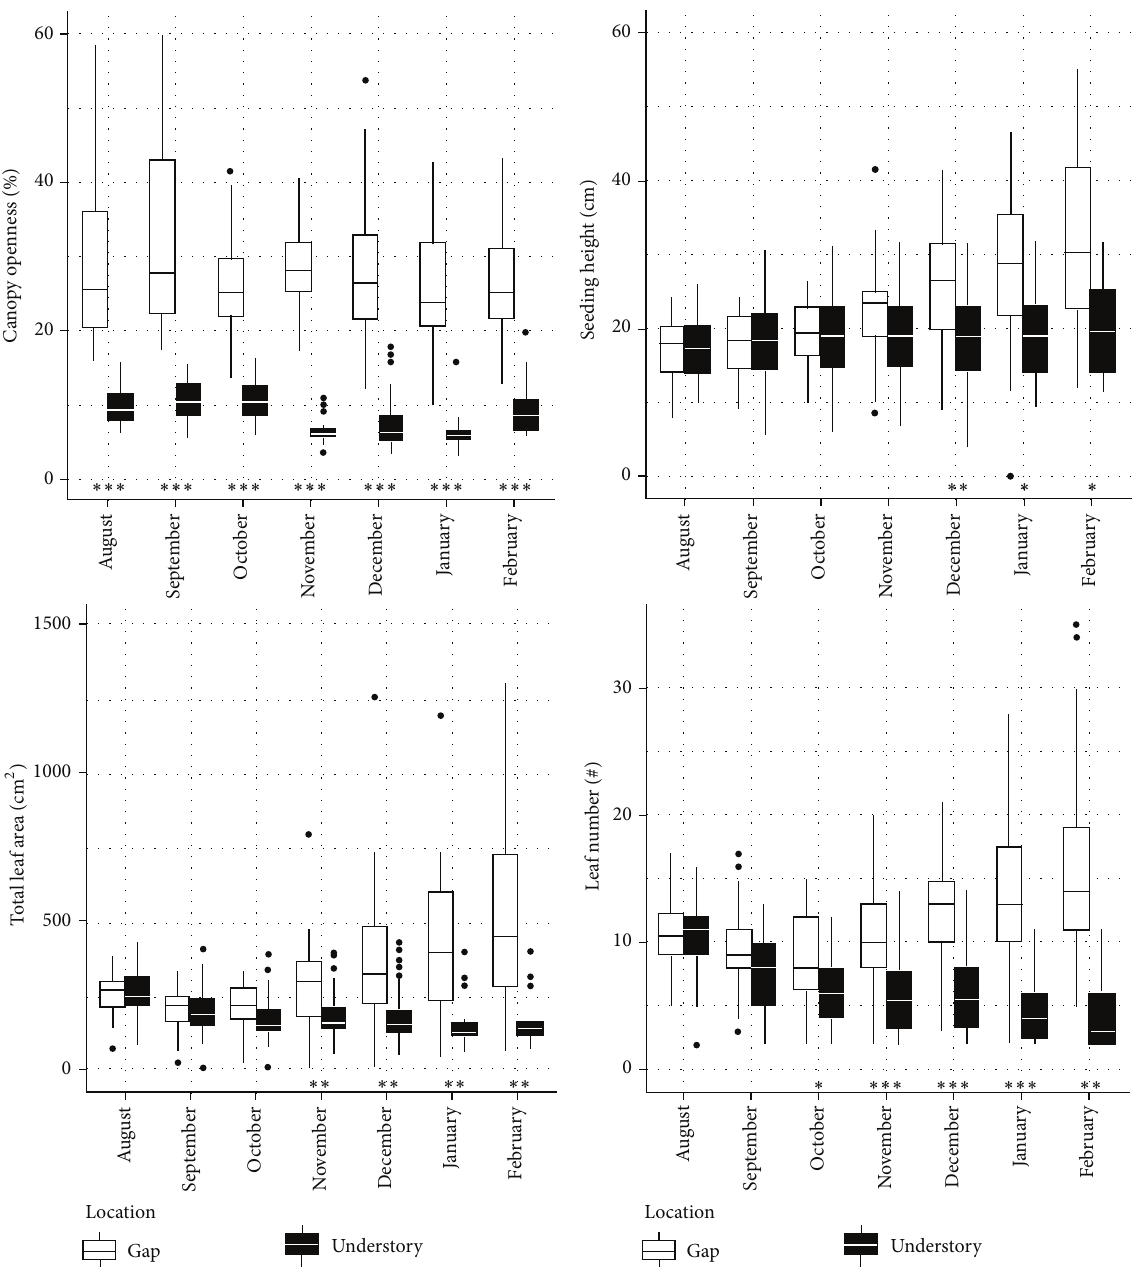
Figure 2: Boxplots showing: openness in tree-fall and understory plots; seedling height in cm from ground; total leaf area in cm 2 ; and leaf number versus measurement month (years 2011-2012). Black boxes represent seedlings in understory sites; white boxes represent seedlings in tree-fall gaps. Significance of difference is provided as 𝑃 value ∗ =< 0.05 , ∗∗ =< 0.01 , and ∗∗∗ =< 0.001